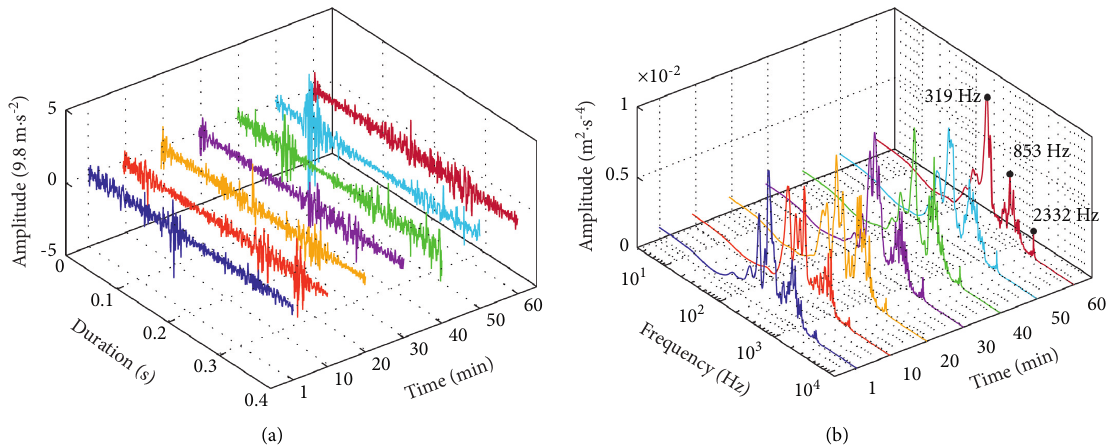
Figure 5: The waveform and power spectrum of original signals under lubricated condition at different moments: (a) the time-domain waveform; (b) the power spectrum.